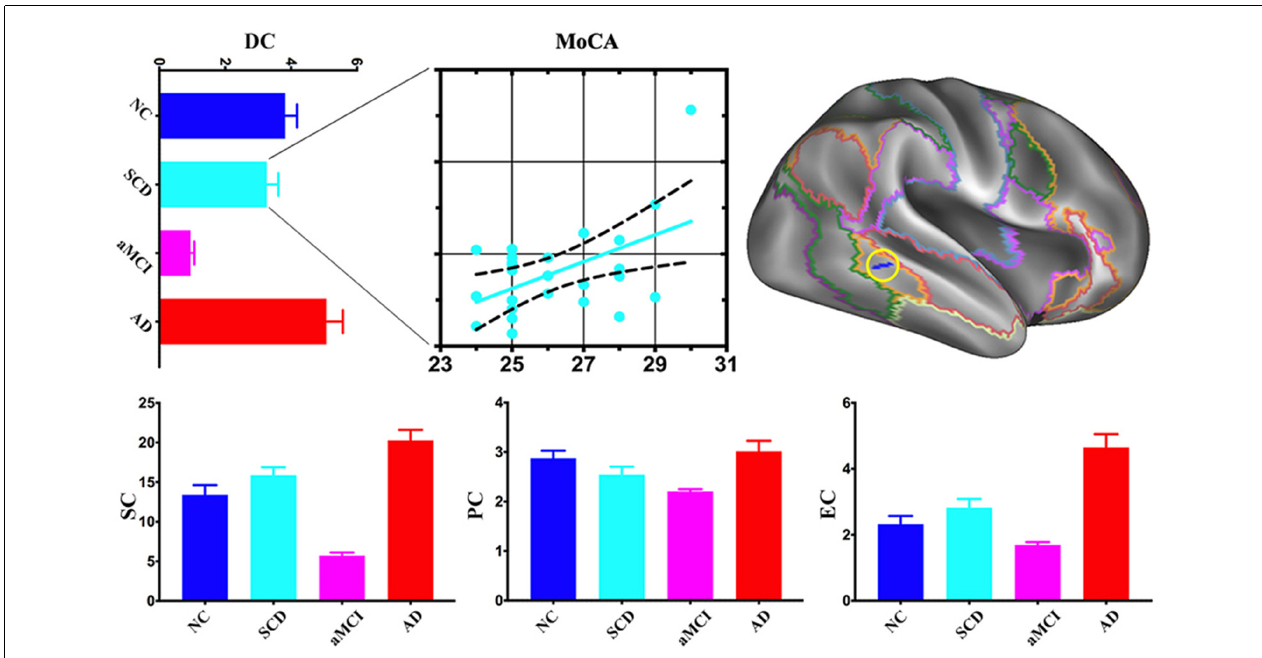
FIGURE 3 | Post hoc cluster-level analyses in the right frontoparietal control network. aMCI showed the lowest centralities at local, meso and global scales in the area of the right frontoparietal control network. The scatter plot exhibited a positive association between mean DC values and Montreal Cognitive Assessment (MoCA) total scores in the SCD ( r = 0.5076, p <